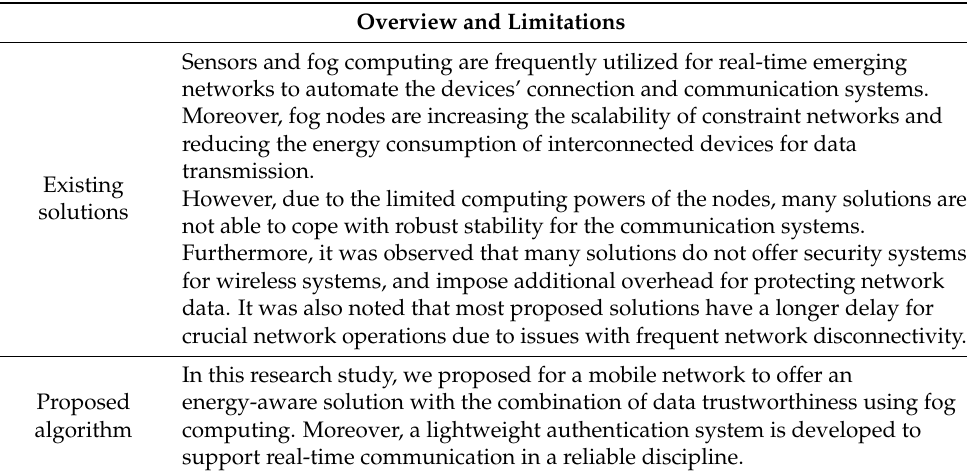
Table 1. Summary of existing related studies. Overview and